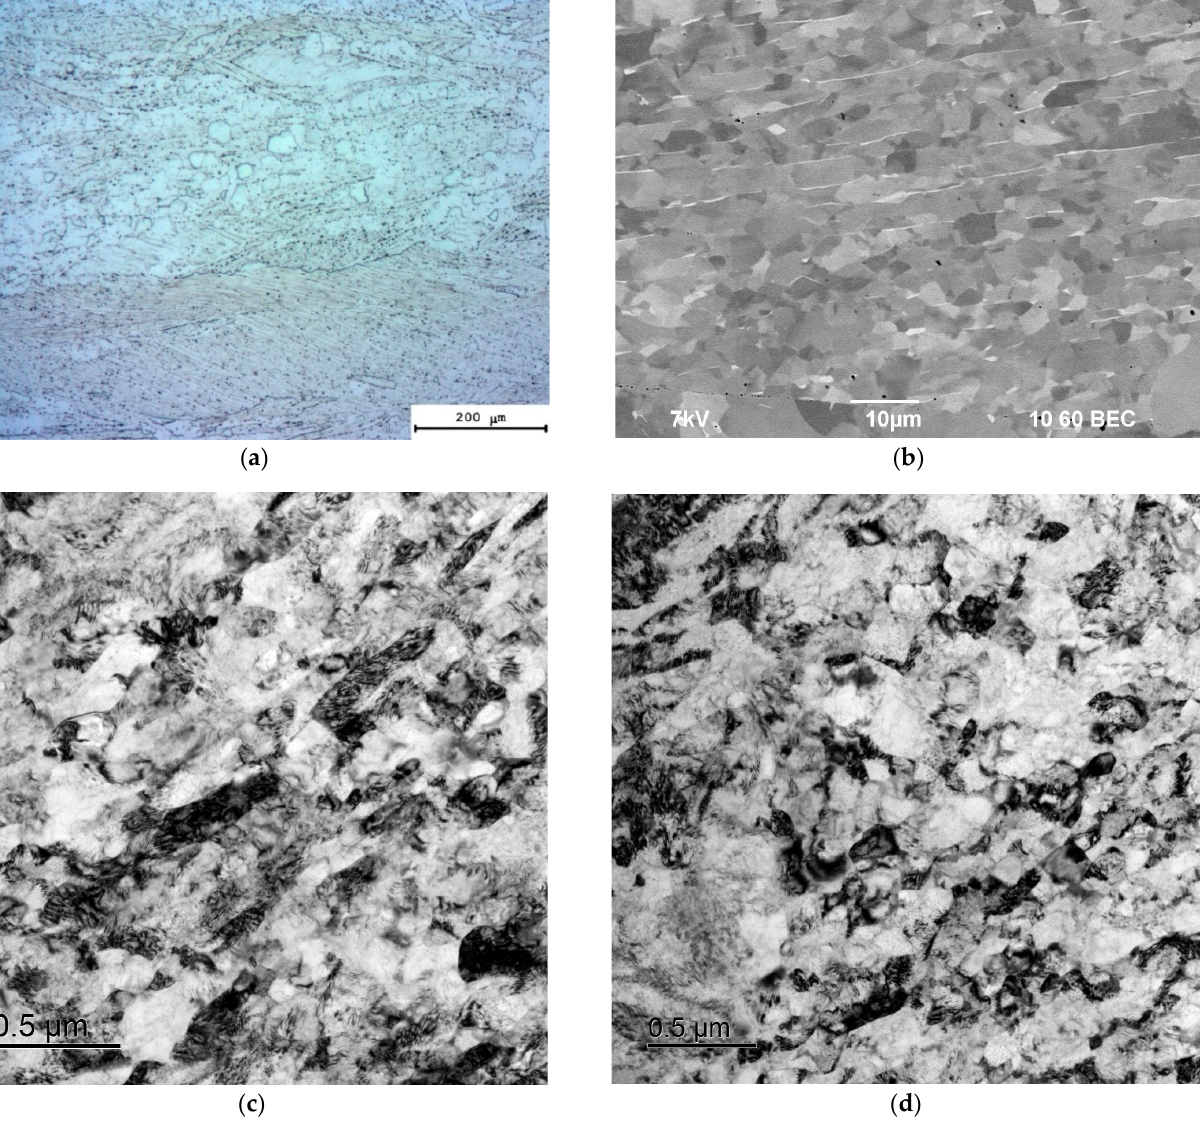
Figure 3. Microstructure in the coarse-grained ( a , b ) and UFG ( c , d ) alloy Ti-5Al-2V, reprinted with permission from [26,50]: ( a ) metallography; ( b ) SEM; ( c , d ) TEM.